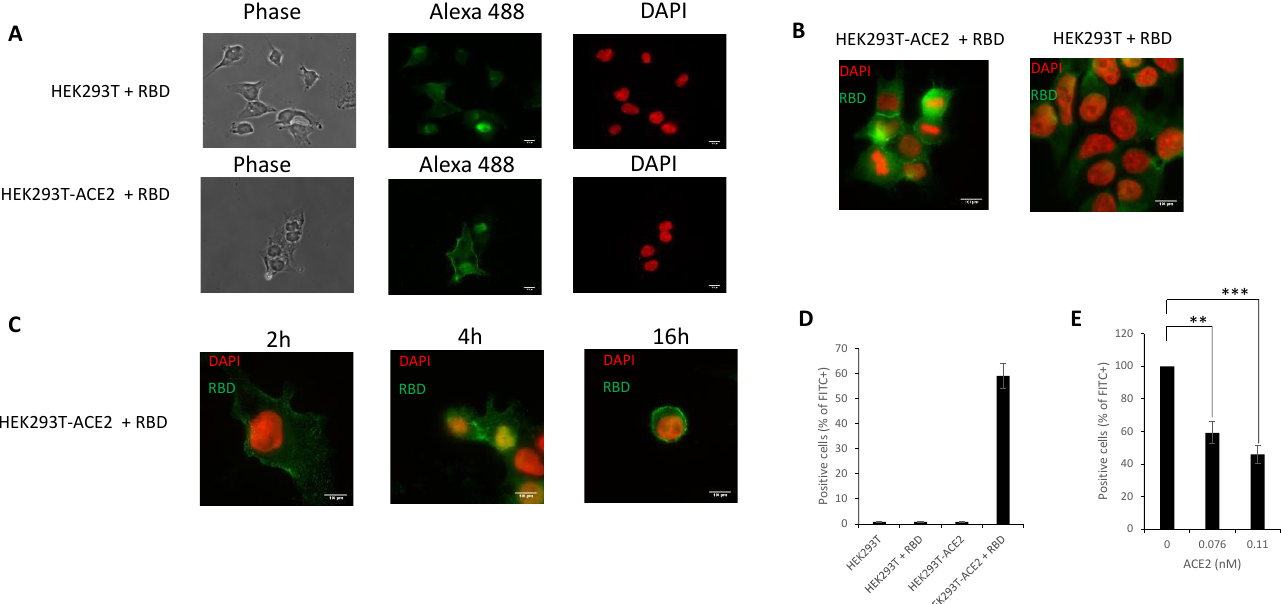
Figure 7. Cell monitoring and quantification of the S-RBD/ACE2 interaction. The SARS-CoV-2 S-RBD fragment was added to either HEK293T or HEK293-ACE2 cells for 16 h and immunofluorescence has been performed using anti-(His) 6 antibody and secondary antibody coupled to Alexa-Fluo 488. Cells were observed by epifluorescence microscopy ( A ). A typical DAPI/Alexa 488 channels merge is reported in ( B ) and RBD distribution profile in HEK293T-ACE2 cells over time is reported in ( C ). Cells were also analyzed using flow cytometry to detect the percentage of cells positive for FITC signal in the absence ( D ) or in the presence of increasing concentration of ACE2 soluble protein ( E ). ** p < 0.05; *** p < 0.001.